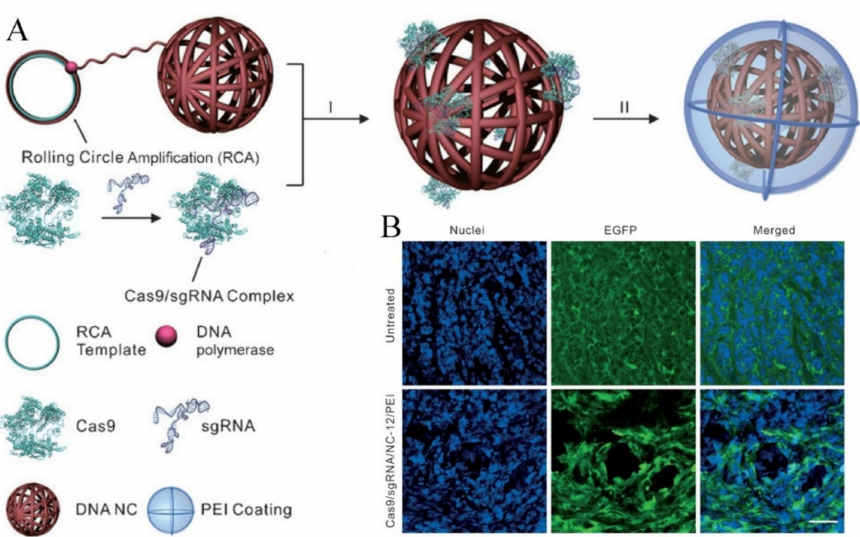
Figure 8. Self-assembled DNA nanoclew for CRISPR/Cas9 RNP delivery. ( A ) Design of the DNA nanoclew to deliver the CRISPR-Cas9 RNP complex. ( B ) In vivo gene editing of Cas9 RNP in U2OS. EGFP xenograft tumors. The EGFP stained by antibodies appears green, and the nuclei appears blue. Approximately 25% of the tumor cells near the injection site showed no EGFP expression and the untreated mice did not show any loss. Reproduced with permission from [58]. Copyright John Wiley and Sons,